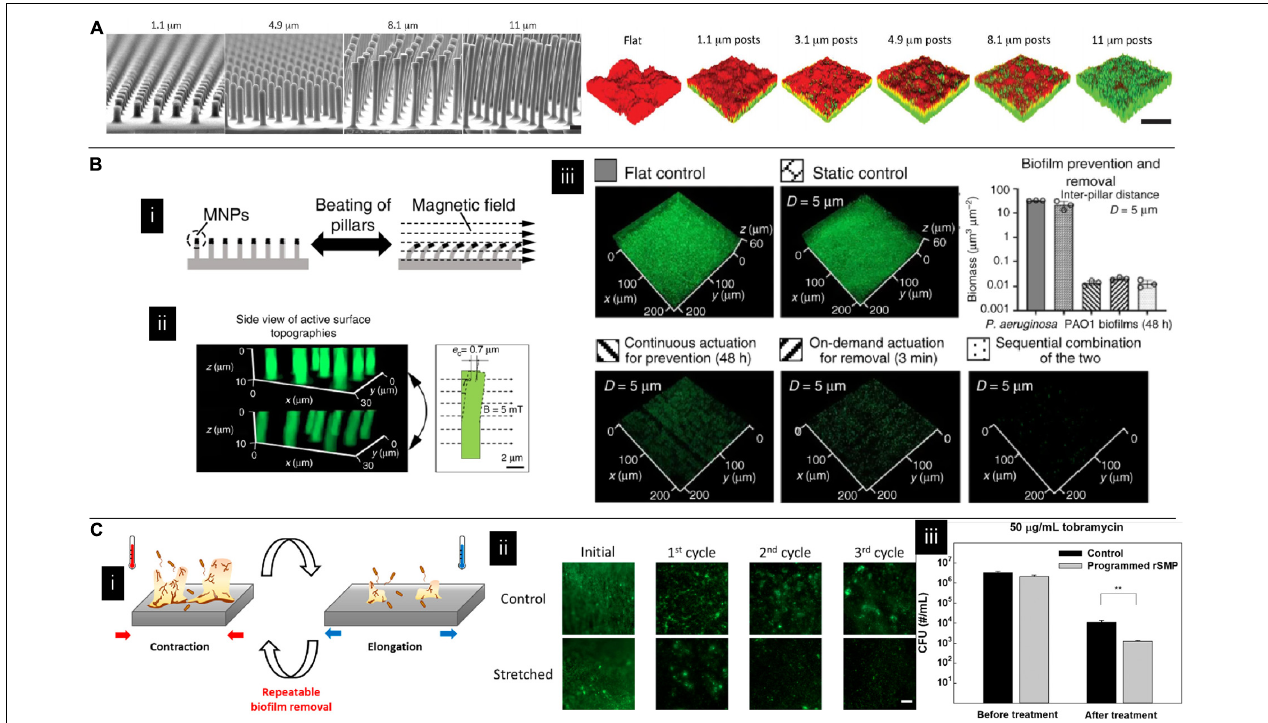
FIGURE 4 | (A) Topography affecting multispecies biofilm morphology and species content where green and red colors indicate Escherichia coli and Pseudomonas aeruginosa, respectively. The fraction of E. coli in the co-cultured film increased with the pillar height (Bhattacharjee et al., 2017). Adapted with permission from Bhattacharjee et al. (2017). Copyright 2017 American Chemical Society. (B) The effect of magnetically driven dynamic pillar pattern on biofilm formation. (i) Schematic image of pillar bending in response to an external magnetic field. (ii) Fluorescent images of the pillar before and after exposure to a magnetic field. (iii) Representative fluorescence images of biofilms on flat controls, static controls, and active surface topographies (Gu et al., 2020). Adapted with permission from Gu et al. (2020). Copyright 2020 Spring Nature. (C) The effect of shape recovery substrate on biofilm formation. (i) Schematic illustration of dynamic substrates. (ii) Biofilm staining on different dynamic substrates. (iii) Detached bacteria were more susceptible to antibiotics on dynamic substrates (Lee et al., 2021).